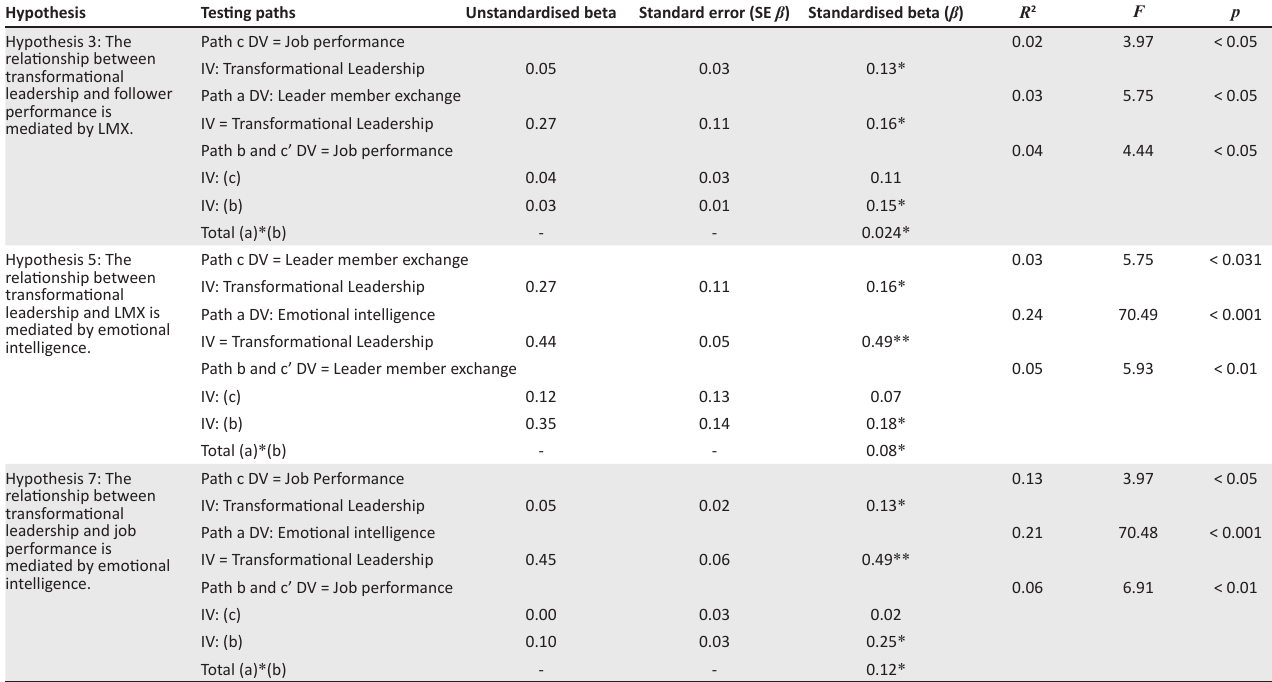
TABLE 6: Mediation analysis. Hypothesis Testing paths